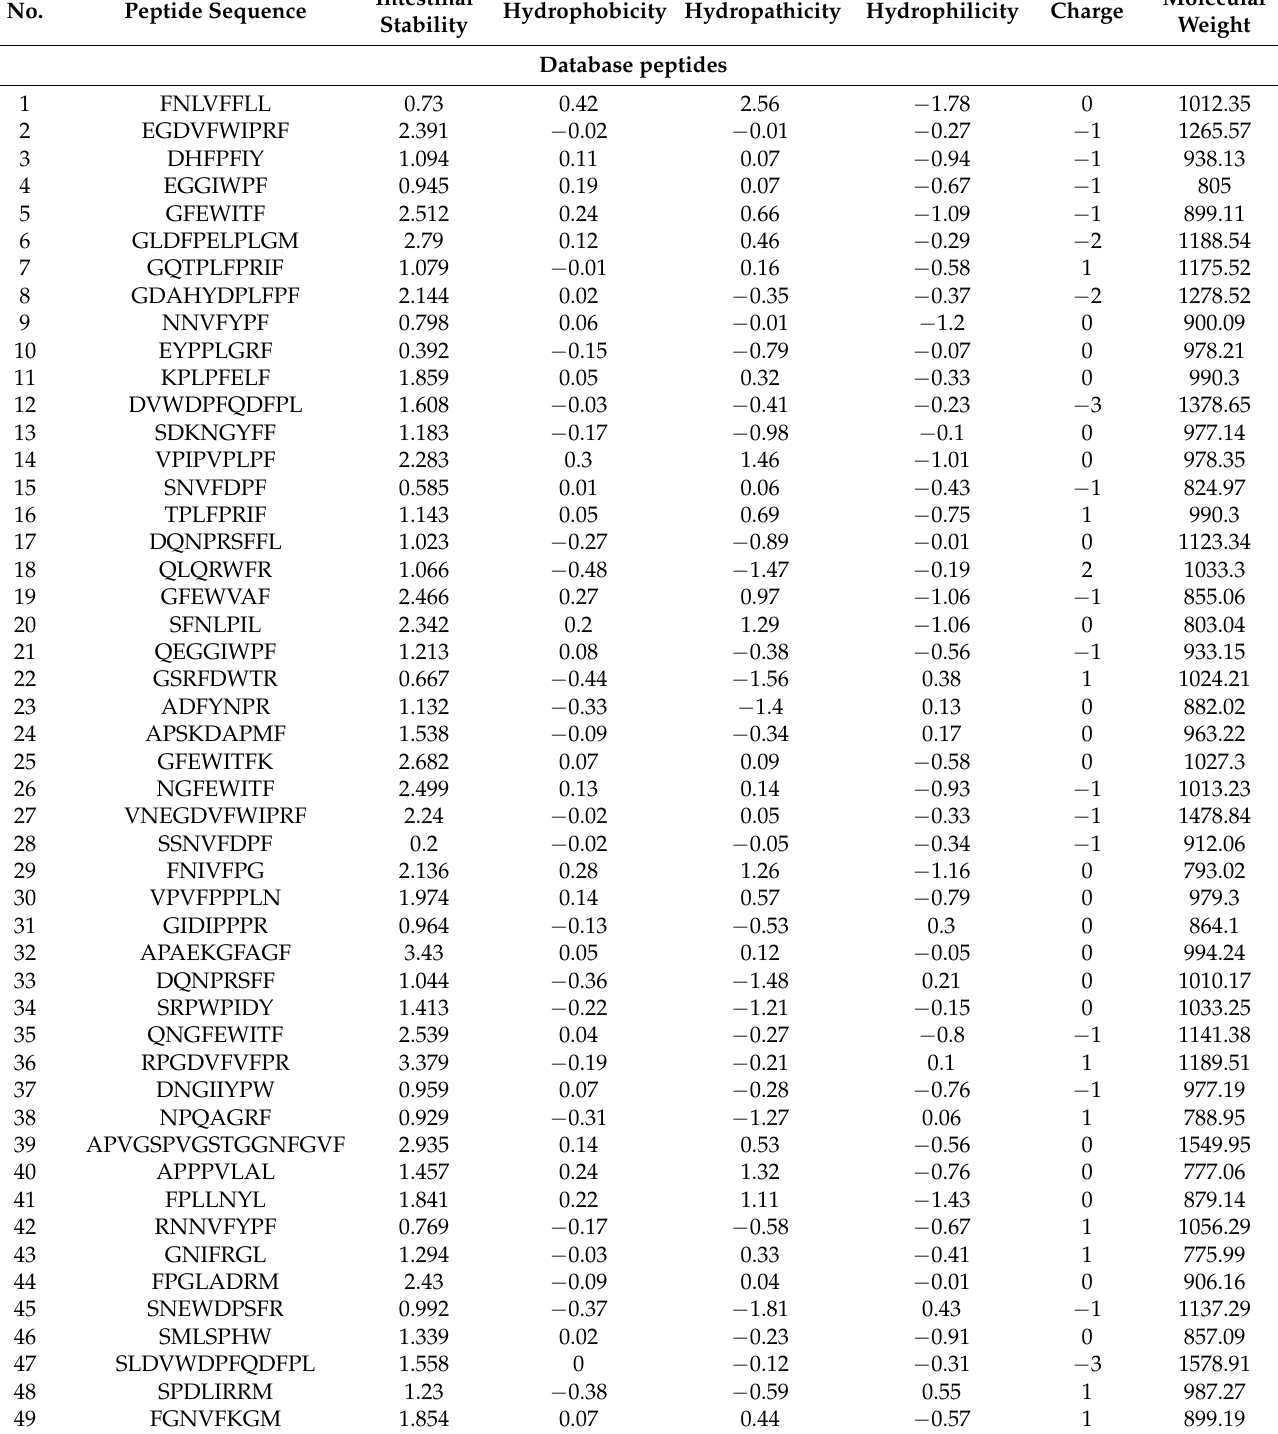
Table 2. Physicochemical chracteristics of selected chia seed peptide